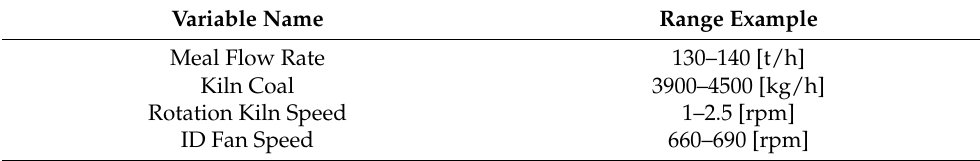
Table 1. Rotary kiln APC system: MVs.